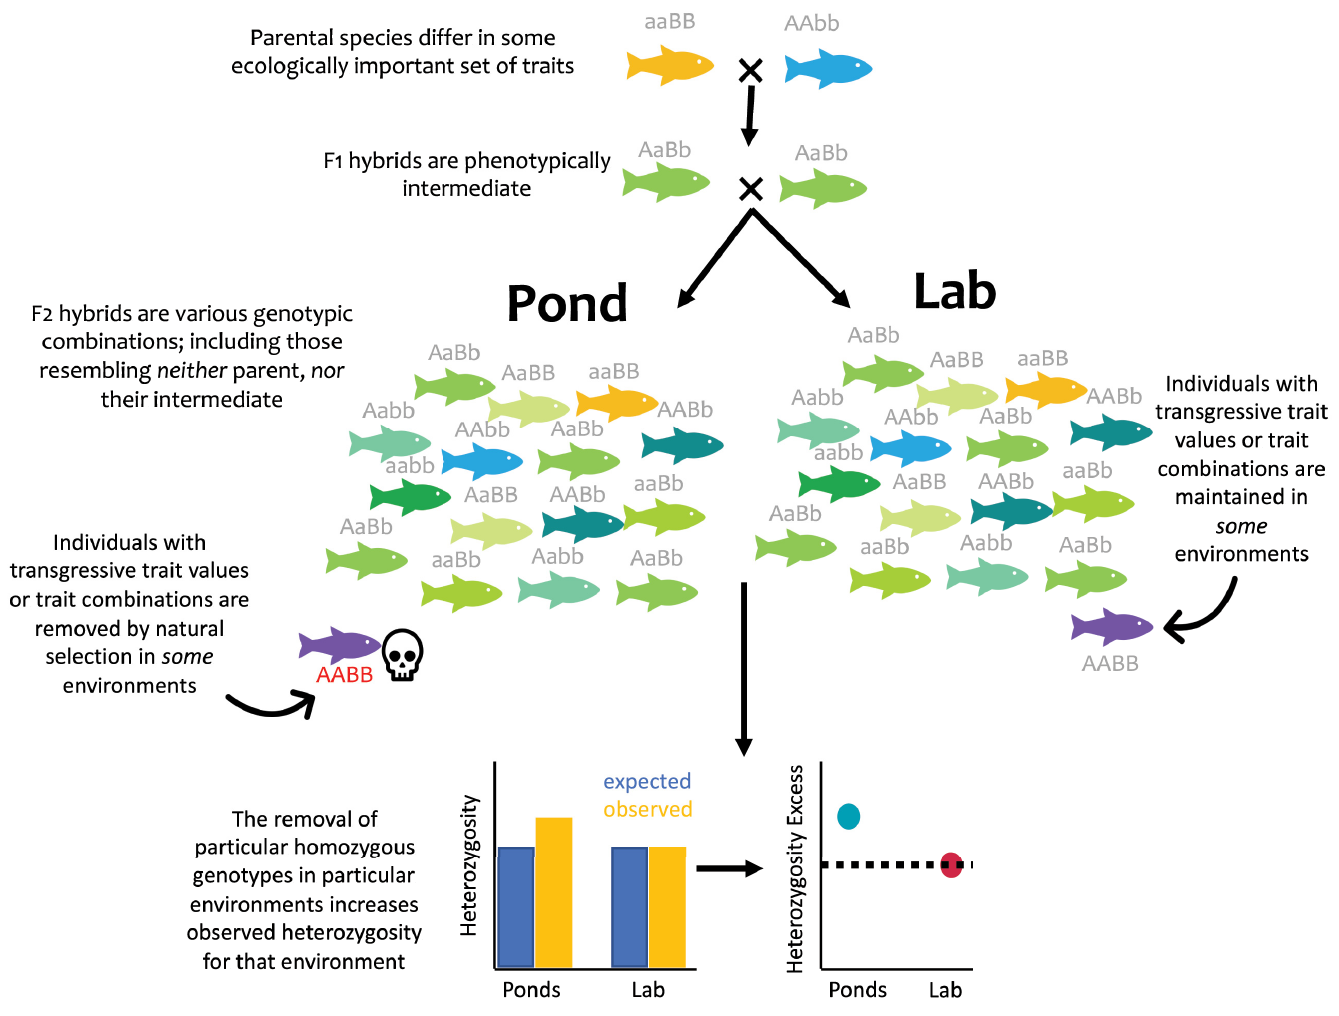
Fig 1. Ecological incompatibilities should leave a detectable genomic signature. F 2 hybrids between 2 ecologically divergent species are raised in both benign lab and natural or seminatural field environments. If the genetic architecture of divergence is largely additive, then most hybrids will exhibit an intermediate set of phenotypes. Yet, a subset of individuals with largely alternate homozygous ancestry at different loci may exhibit trait mismatches or transgressive traits (shown in purple). If these individuals are selected against, then heterozygosity of the surviving hybrids will be elevated relative to the expectation based on allele frequencies. Under a model of ecological incompatibility, this excess heterozygosity should be observed only in natural